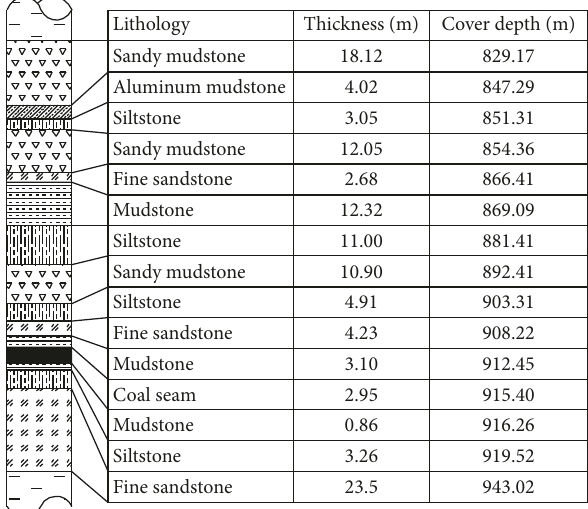
Figure 5: Generalised stratigraphy column of the test